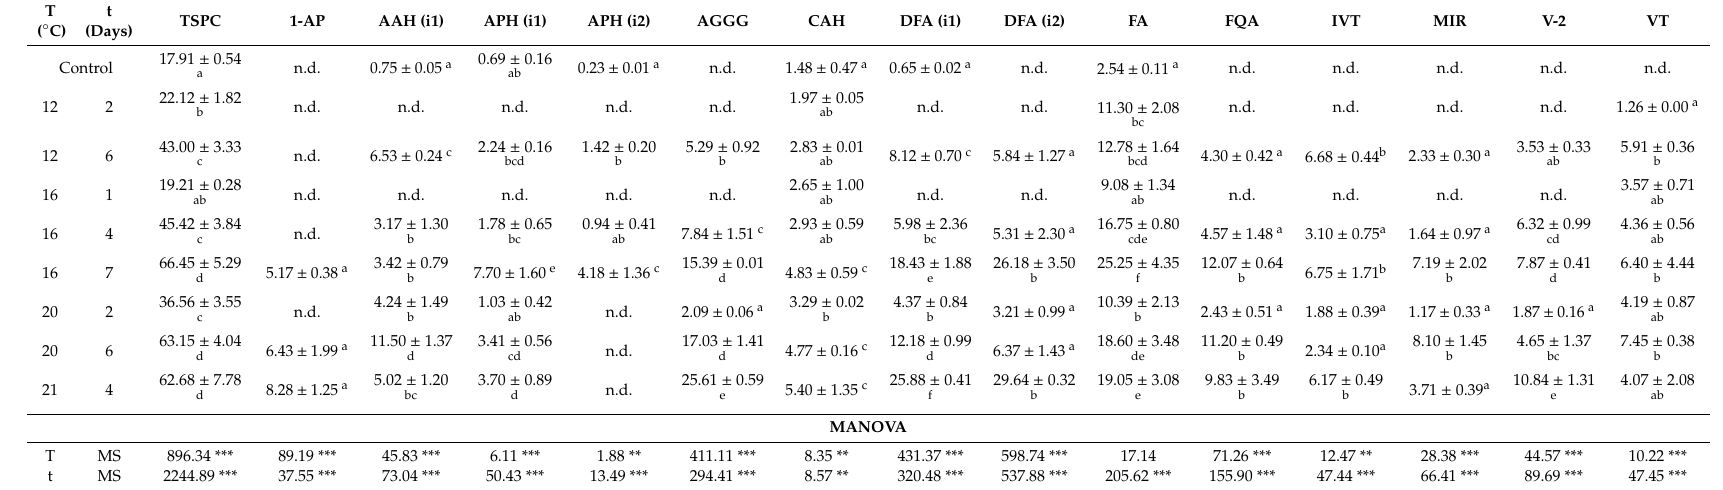
Table 1. Total soluble and individual phenolic content of whole-wheat grain (control) and sprouts obtained at di ff erent temperatures and